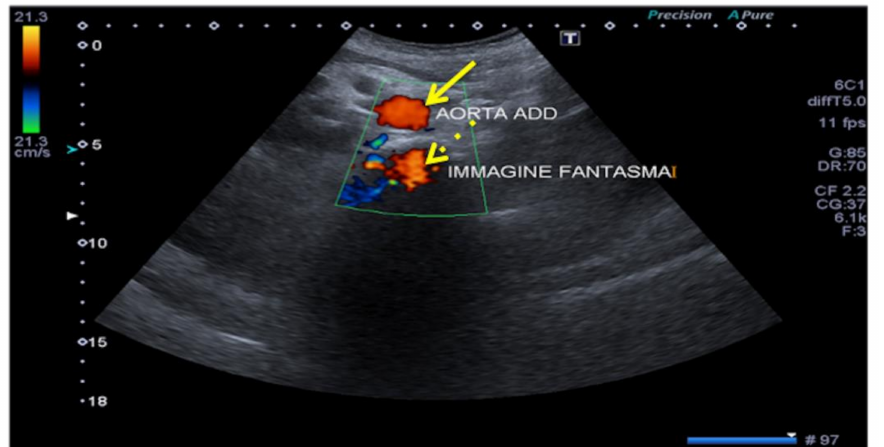
Figure 5. Aorta ghosting. Transverse mesogastric color-Doppler US image obtained at the level of the infra-renal aorta (arrow) shows aorta ghosting (dashed arrows) that projects backwards with the same color sign.